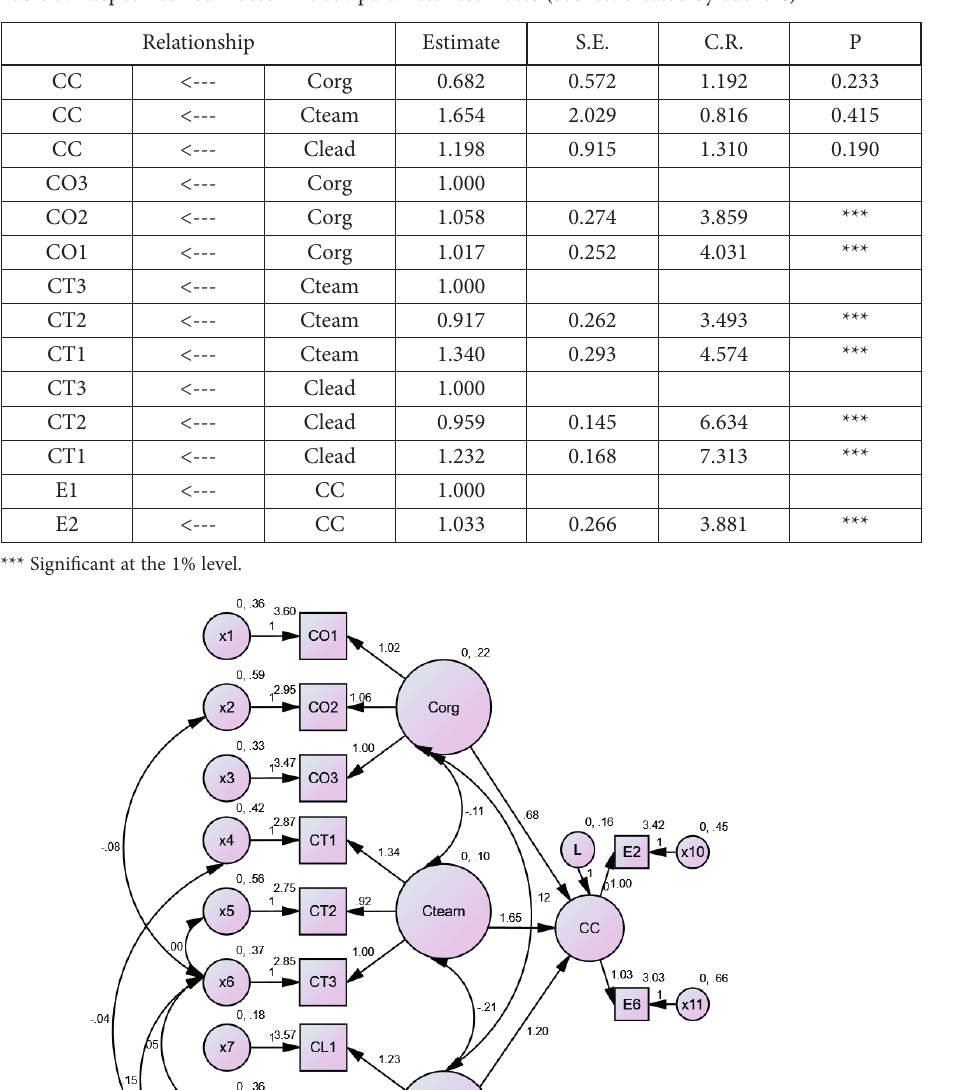
Table 3. Respecified four-factor model: parameter estimates (source: created by authors)